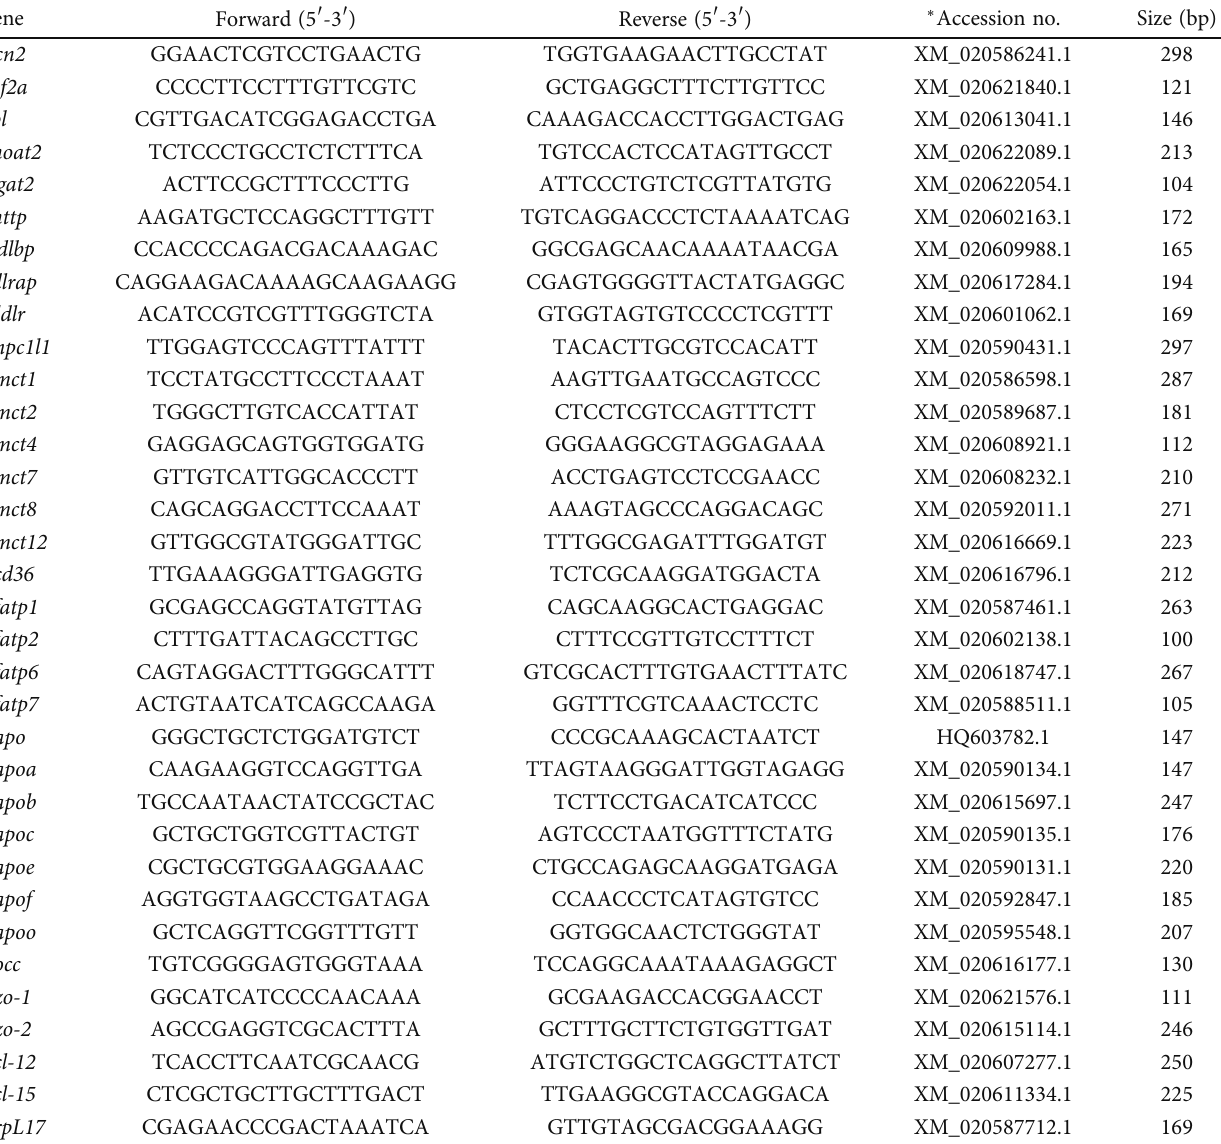
Table 4: Primer sequence for